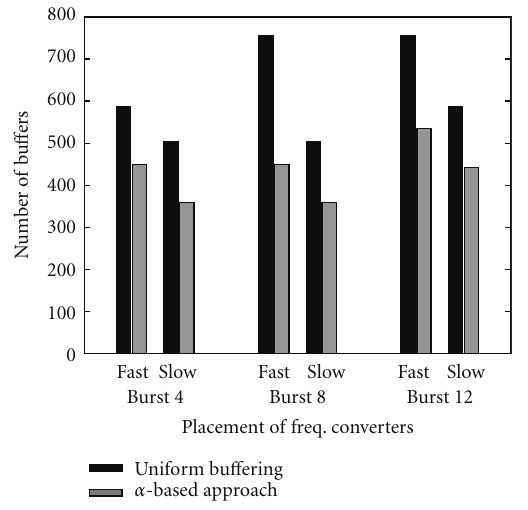
Figure 11: Placements of FCs.